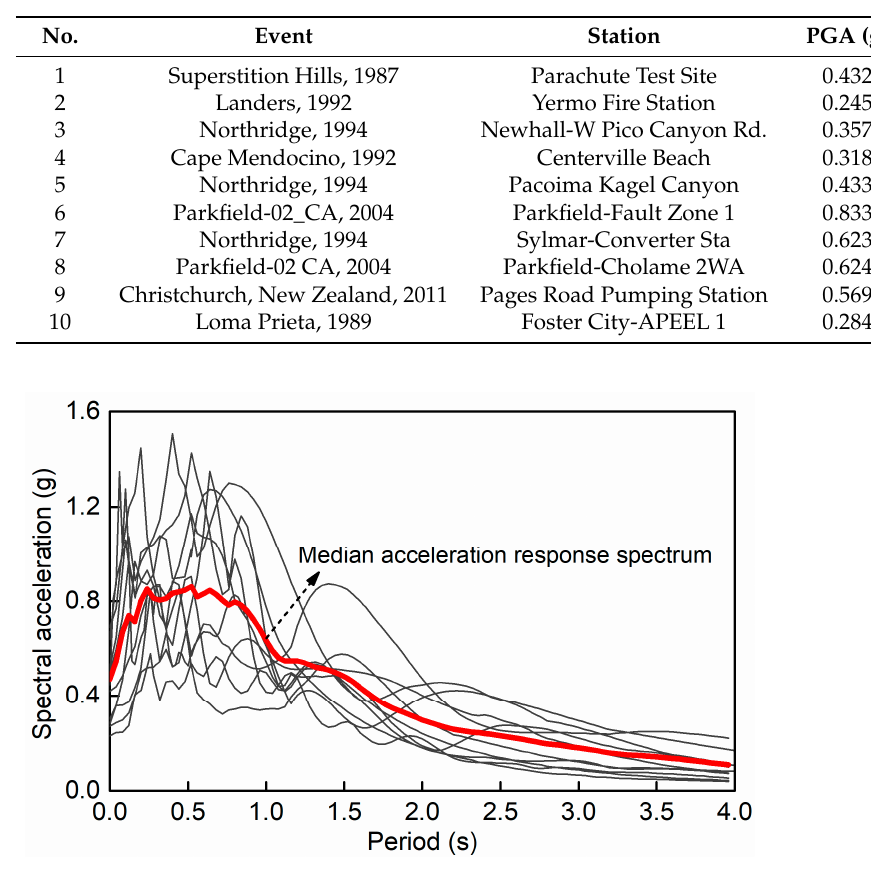
Figure 15. Acceleration response spectrum of the ground motions.